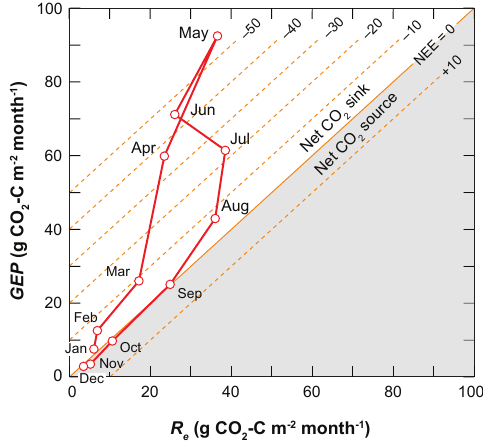
Figure 3. Monthly gap-filled R e ( x axis) drawn against GEP ( y axis). The resulting NEE can be read off the diagonal lines. The thick 1:1 line shows carbon neutrality, while lines in the upper right are of increasingly negative NEE (uptake) and lines towards the lower right are positive NEE (net